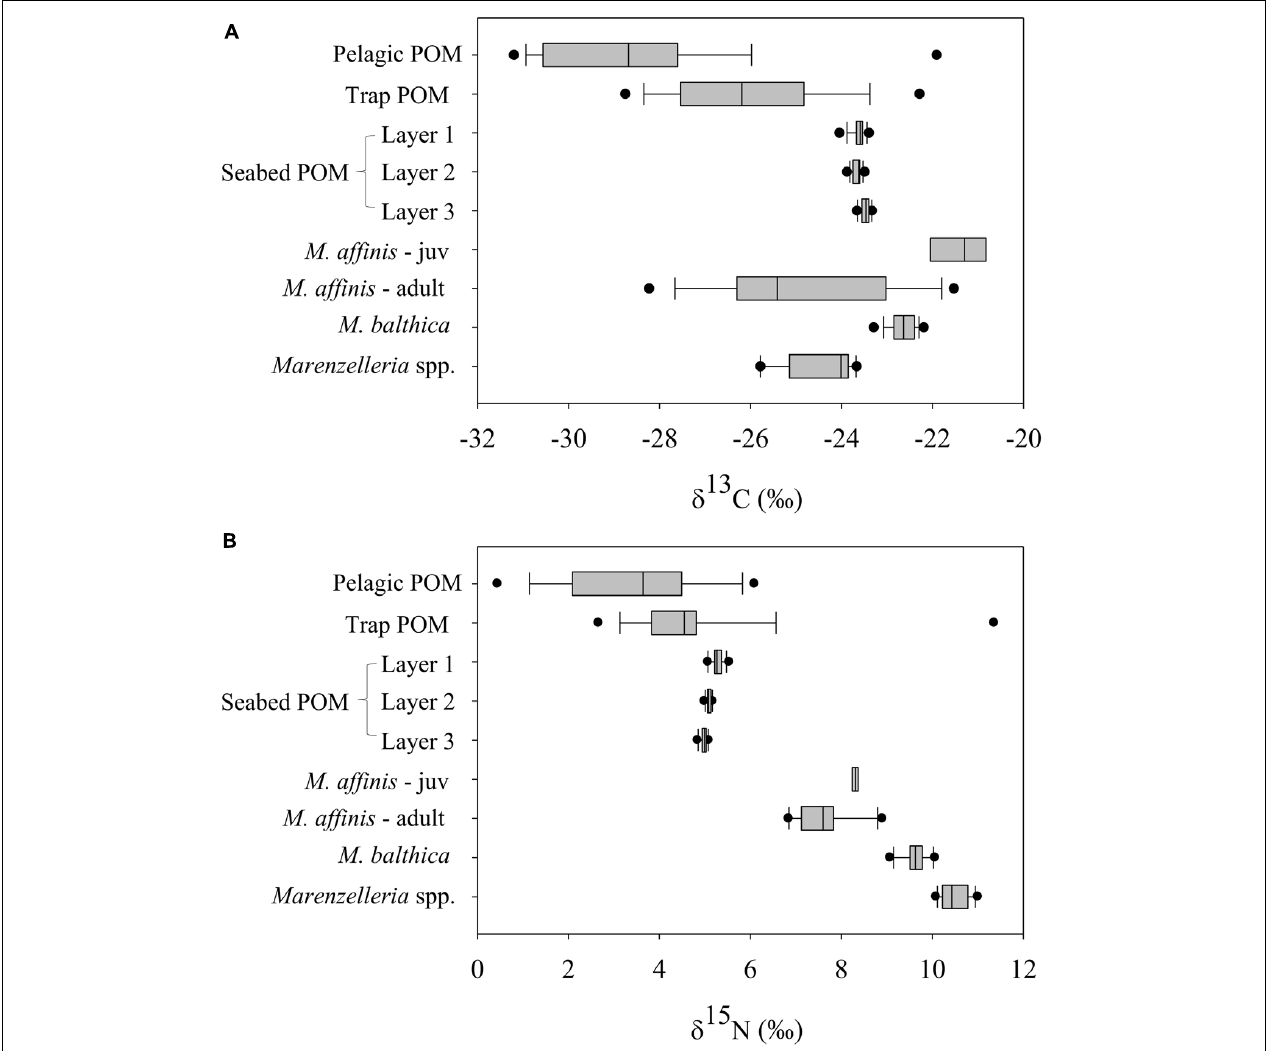
FIGURE 5 | Median and percentiles (10th, 25th, 75th, and 90th) with error bars of the stable isotopes δ 13 C (A) and δ 15 N (B) for the main particulate organic sources collected from the different compartments (SPOM from the water column, POM from the sediment traps, and seafloor POM from the different sediment layers) and the main benthic consumers ( Macoma balthica , Marenzelleria spp., and Monoporeia affinis in both adult and juvenile stages) over time (from February to November